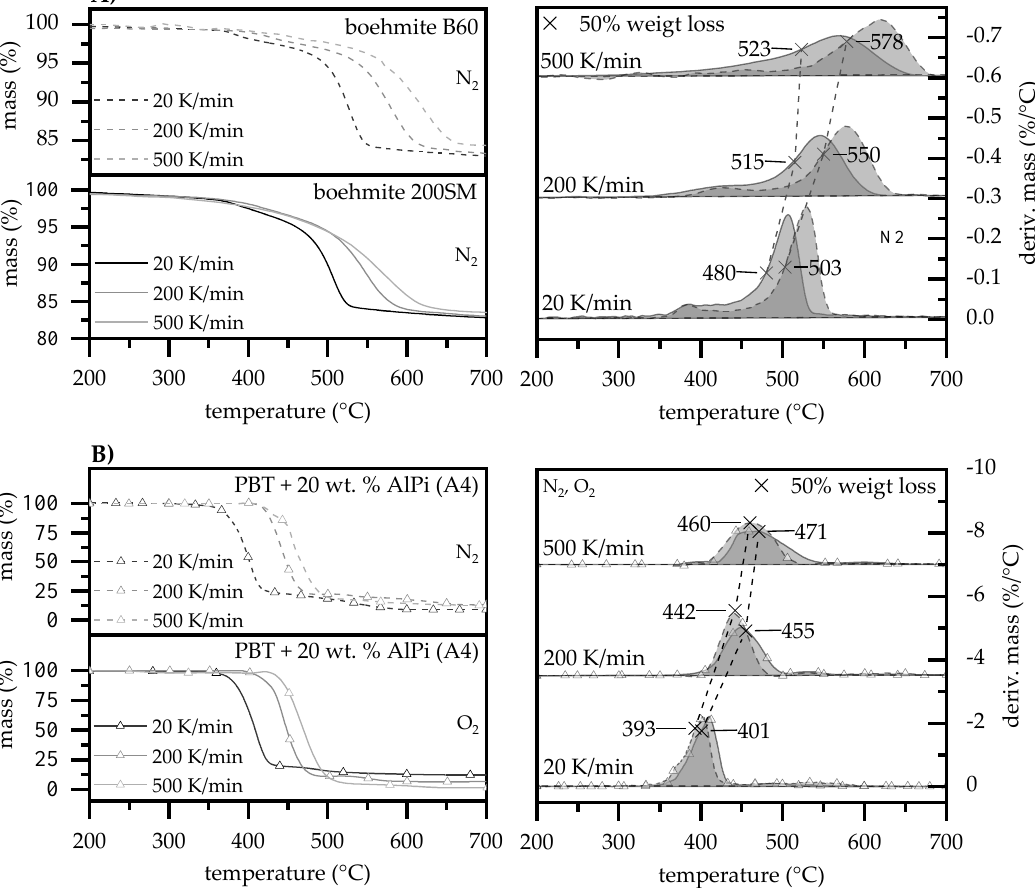
Figure 8. TGA measurements at heating rates 20, 200 and 500 K/min under nitrogen and oxygen atmosphere. Temperature at 50% weight loss measured by total mass loss are marked and connected by a dotted line for ( A ) pure boehmite ( B ) PBT modified by 20 wt. % AlPi.